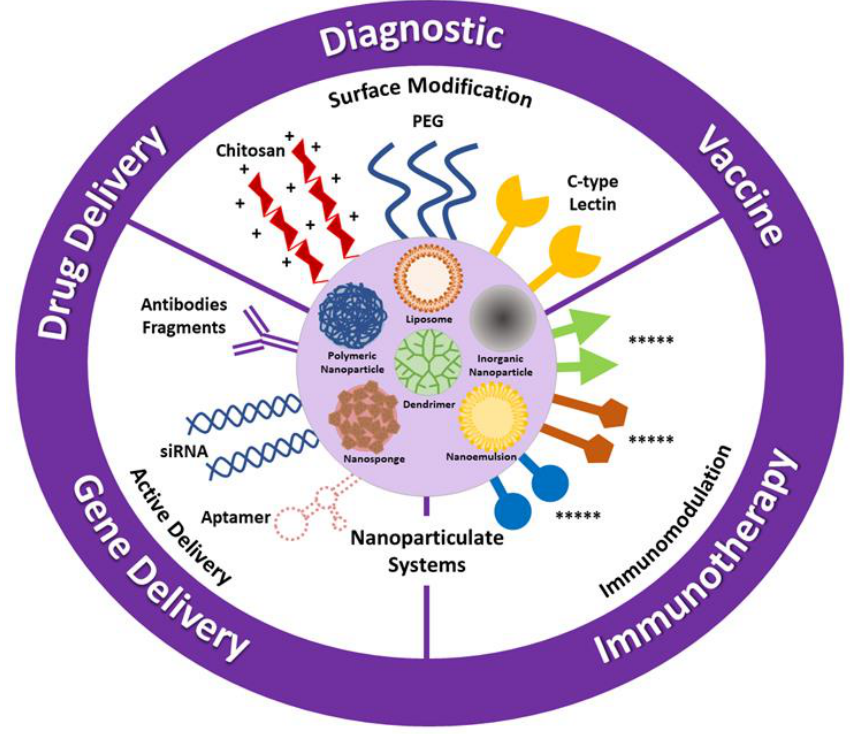
Figure 5. Various types of nanoparticulate delivery systems and possible approaches in cancer therapy .